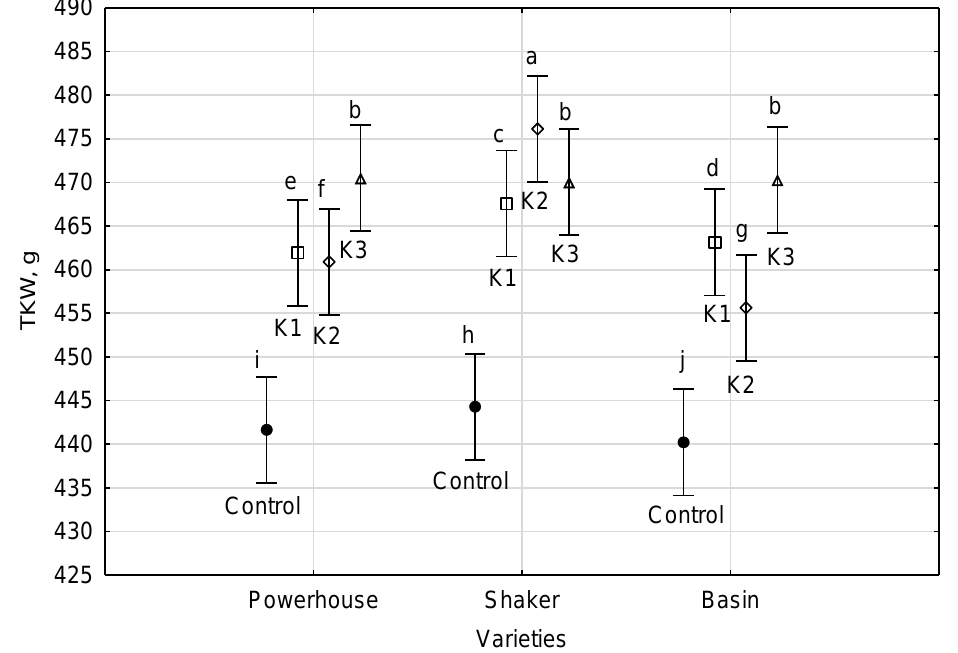
Figure 5. The thousand kernels weight (TKW) changes with 95% confidence intervals relative to the number of light exposures and respective cultivars (mean of two years). Means with the same letter are not significantly di ff erent from each other ( p < 0.05—ANOVA followed by Tukey test). Error lines represent ± standard deviation of the